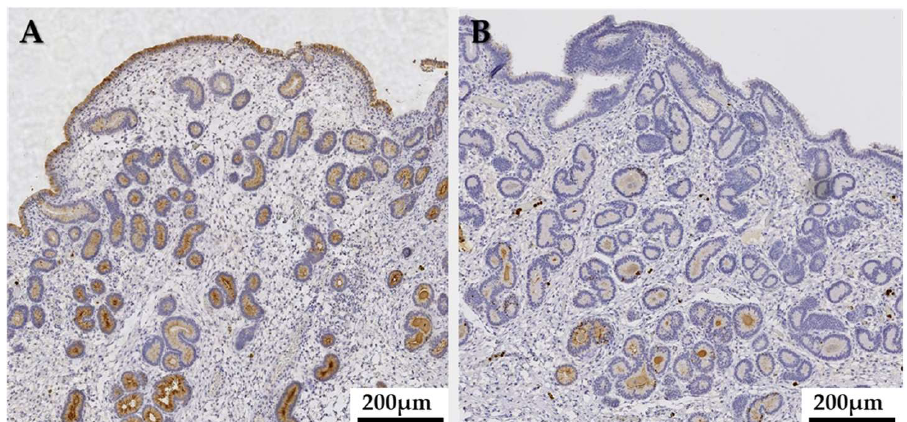
Figure 3. Immunohistochemistry. Endometrial myeloperoxidase (MPO) expression: comparison of MPO immunostaining of a mare through the same estrus cycle, ( A ) in estrus, a widespread distribution of immunopositive endometrial cells is observed; ( B ) In diestrus, endometrial cells showed only residual immunostaining. Magnification 10 ×